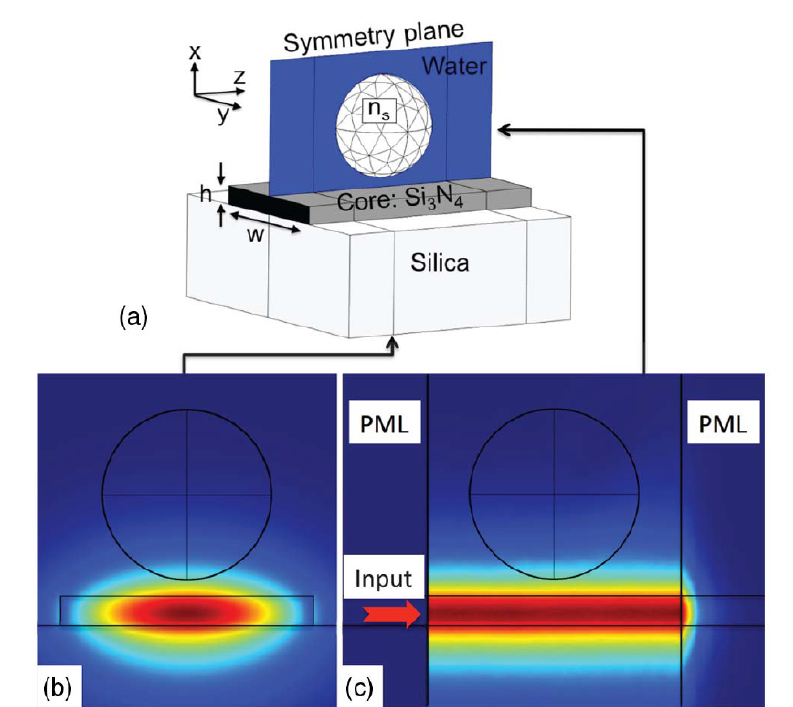
Figure 6. Outline of the model by Hellesø with ( a ) a sphere 100 nm above strip waveguide and ( b ) the fundamental TE mode used to excite the waveguide with 1 mW power as shown in ( c ) as well. Reprinted with permission from [59] © The Optical